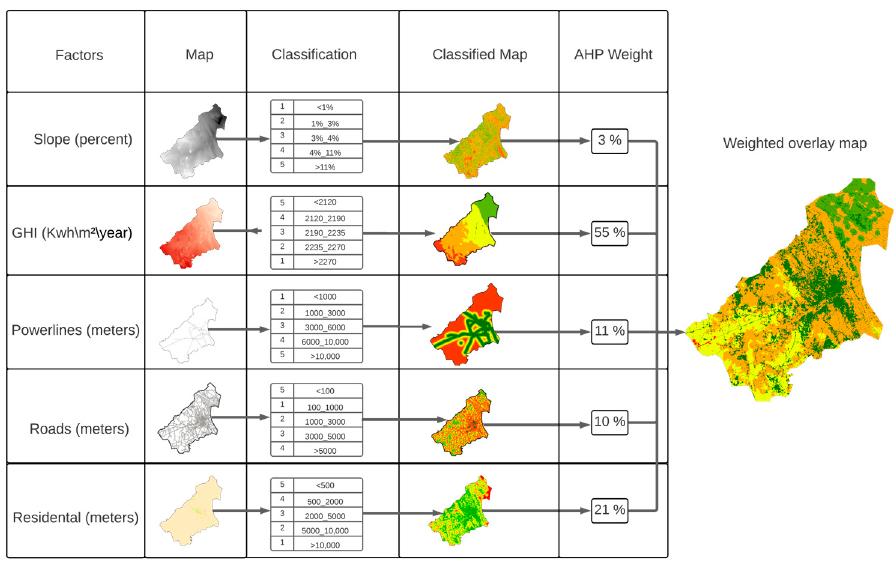
Figure 4. Steps of producing the weighted overlay map for the suitability analysis.